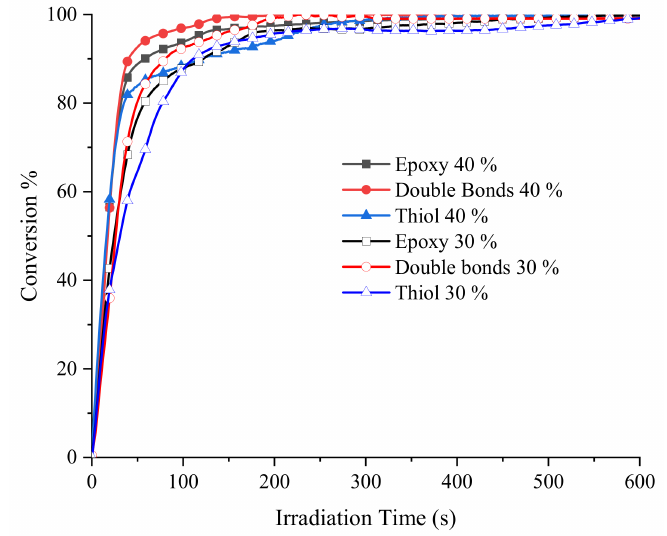
Figure 4. Conversion vs times curves for epoxy groups, thiol groups and double bonds when the TES was added to the epoxy resin at 30 mol % and 40 mol %. The samples were irradiated at 40 mW/cm 2 and 85 ◦ C using 1 mol % of DMPA. Table 2. Summary of conversions and photopolymerization rates of double bonds of LCA, epoxy groups of SR GreenPoxy 28 and thiol groups of PTKMP during the ETE photopolymerization. Double Bonds Epoxy Groups Thiol Groups (1646 cm − 1 ) (867 cm − 1 ) (2552 cm − 1 Formulation